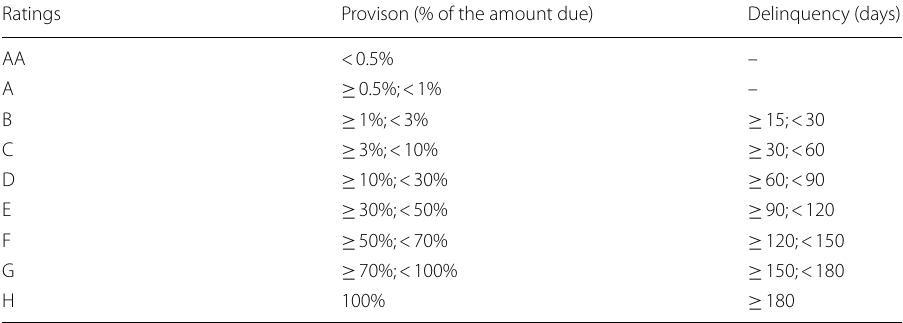
Table 1 Ratings, provision and delinquency in Brazilian financial regulation Ratings Provison (% of the amount